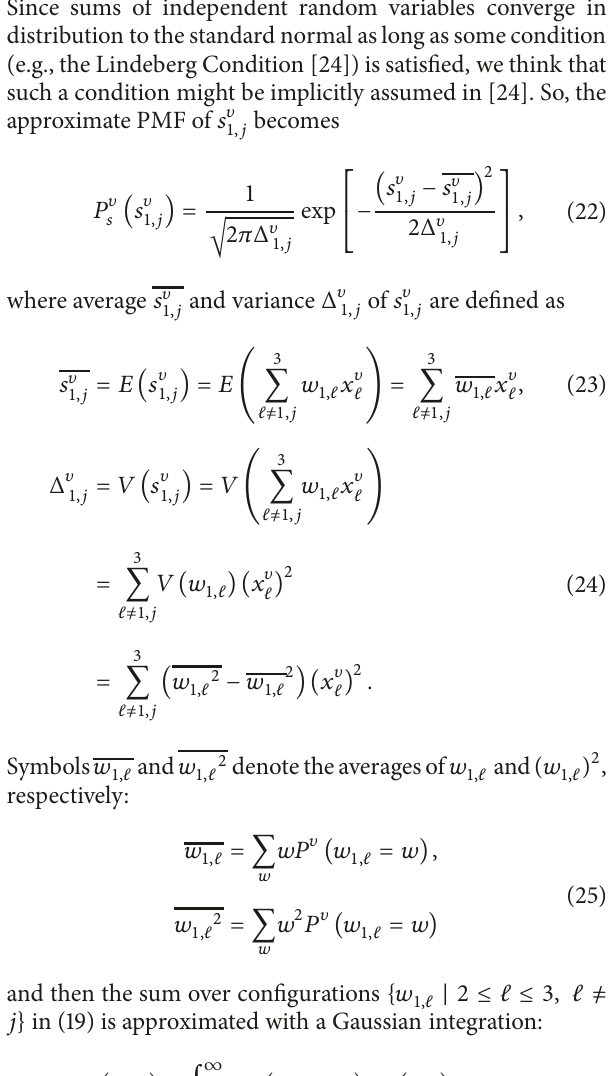
𝜐 in (16) becomes